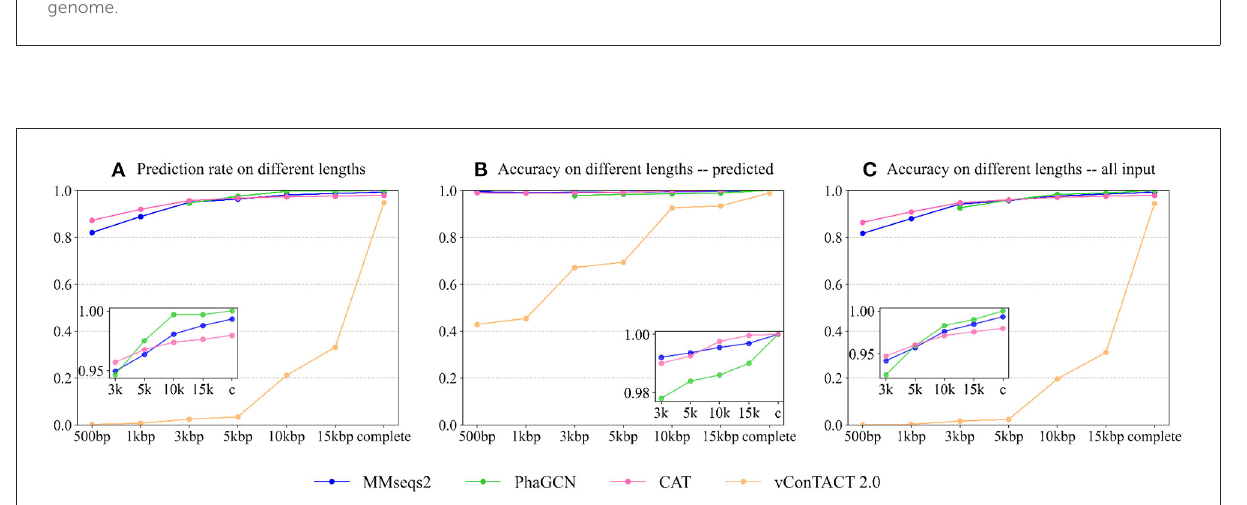
FIGURE4 The performance of each tool on contigs from the RefSeq. (A) The prediction rate of four tools on different lengths. (B) The accuracy of four tools on phage contigs with predictions. (C) The accuracy of four tools on all input phage contigs. X-axis: The lengths Y-axis: The values.